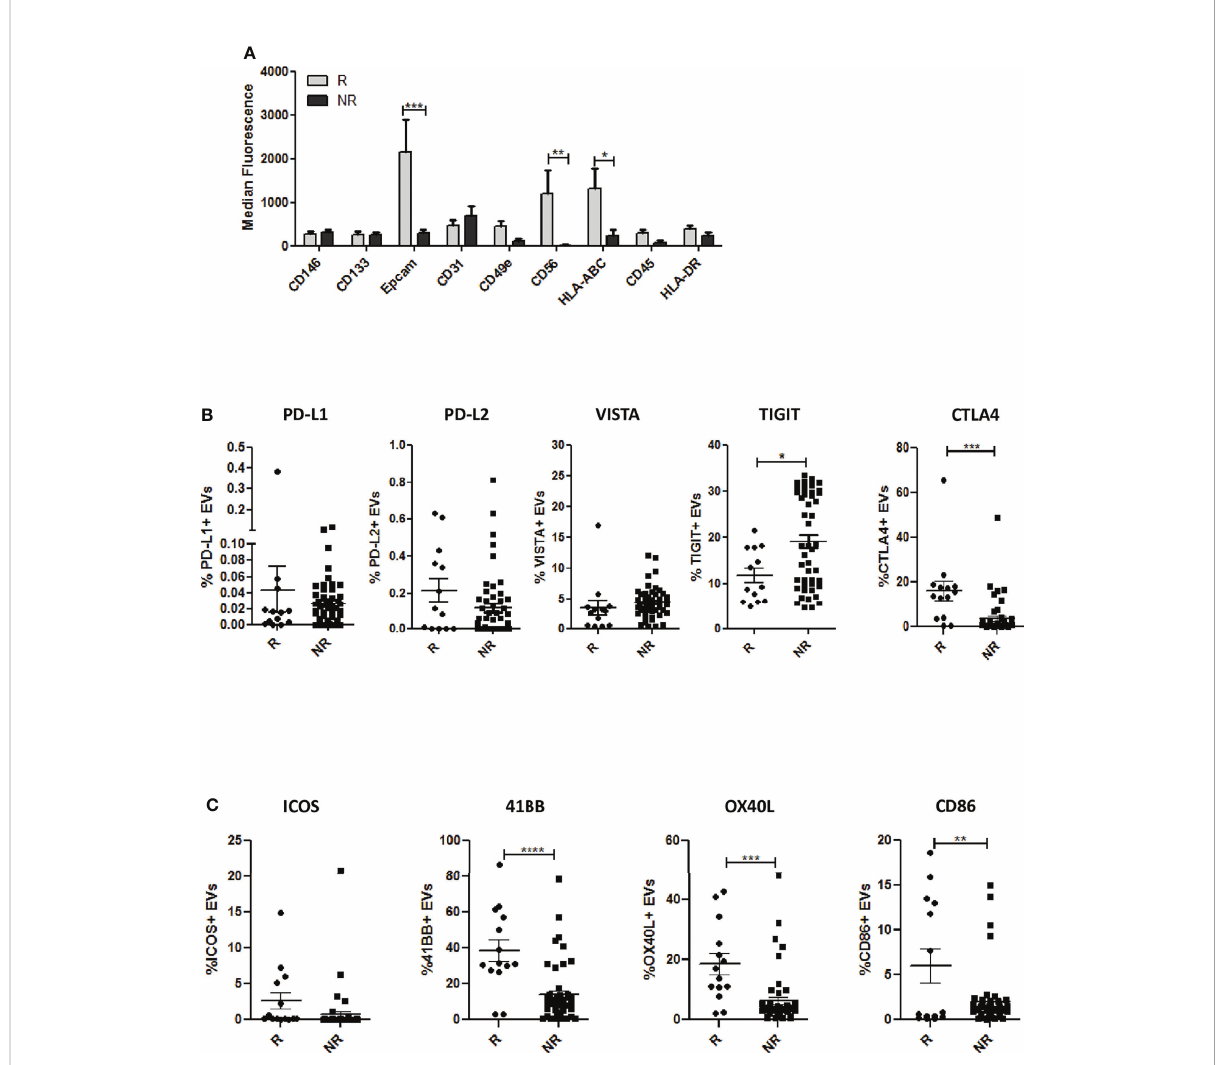
FIGURE 2 Phenotypic analysis of EVs. (A) Pro fi les of surface markers determined by MACSPlex Exosome Kit in EVs from R and NR patients. The values are the median fl uorescence intensities (R n = 8; NR n = 10). (B) Surface expression of inhibitory molecules PD-L1, PD-L2, VISTA,TIGIT and CTLA4 on EVs from R (n = 13) and NR patients (n = 51), evaluated by fl ow cytometry. (C) Surface expression of co-stimulatory molecules (CD86, 41BB, ICOS and OX40L) in EVs from R (n = 13) and NR patients (n = 51), measured by fl ow cytometry. The data are expressed as the mean ± S.E.M. values. (*p < 0.05; **0.05 < p < 0.001; ***0.001 < p < 0.0001; ****p <